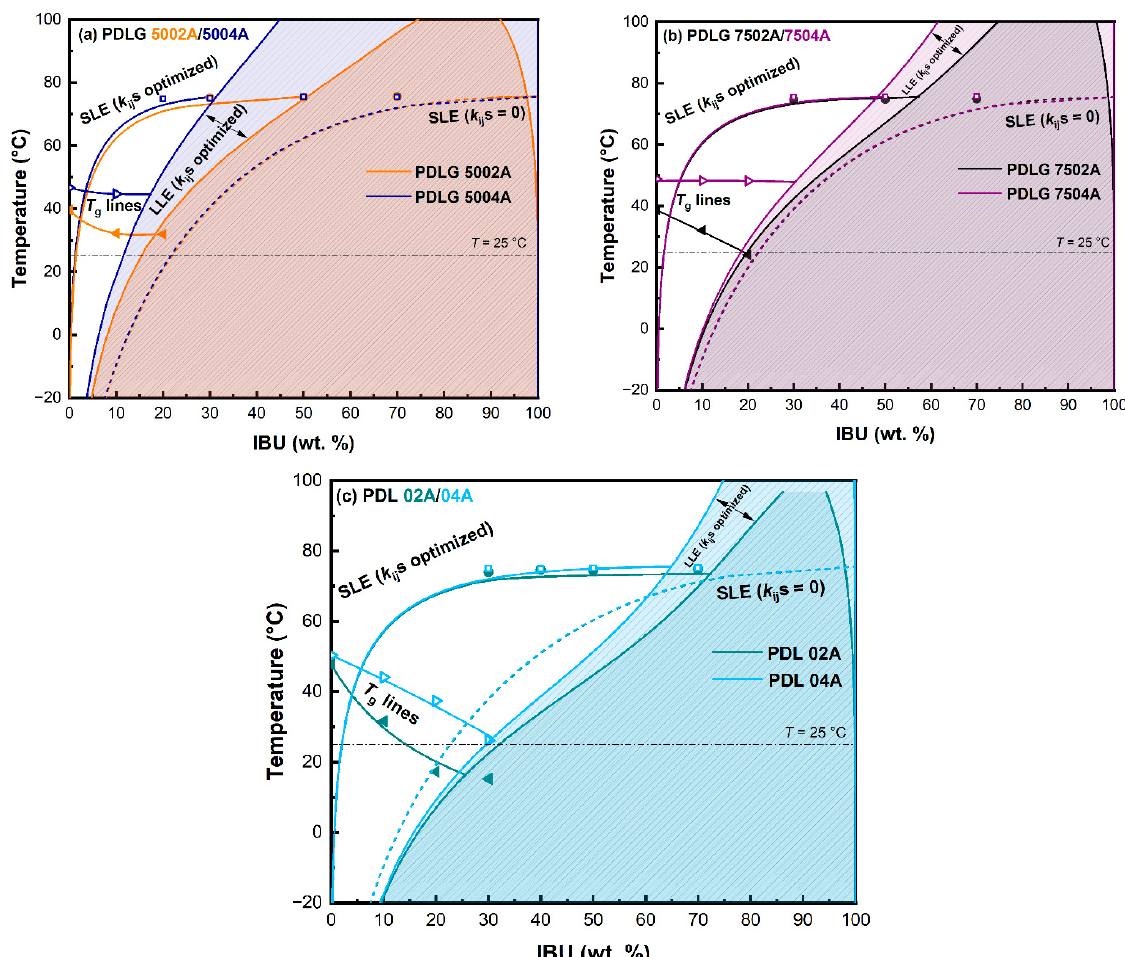
Figure 2. IBU–PLA/PLGA phase diagrams: ( a ) IBU–PDLG 5002A/PDLG 5004A, ( b ) IBU–PDLG 7502A/PDLG 7504A, and ( c ) IBU–PDL 02A/PDL 04A. Symbols represent experimental values and lines represent the calculated properties. T g lines were modeled by the Kwei equation, Equation (1), and SLE and LLE using the PC-SAFT EOS. Experimental T g and SLE values are listed in Tables S1 and S2, respectively; parameters of the Kwei equation, Equation (1), are listed in Table S3; and applied binary interaction parameters k ij are listed in Table S5. Data for IBU–PDLG 5002A and IBU–PDLG 7502A were taken from our previous study [14].